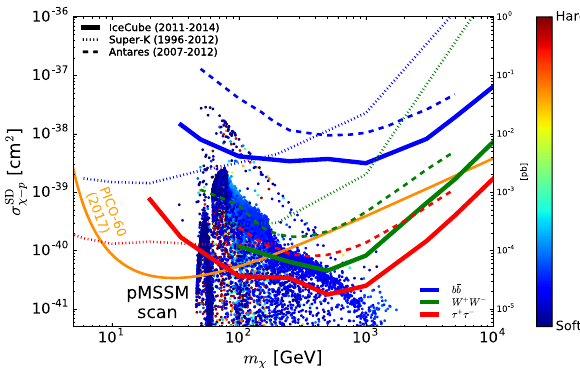
Fig. 23 IceCubelimitsonthespin-dependentWIMP-protonscattering cross section, σ SD χ − p as a function of WIMP mass, compared to results from other neutrino detectors and direct detection experiments [210, 218,219]. The IceCube limits have been scaled up to the upper edge of the 1 σ systematic uncertainty band. The coloured points correspond to models from a scan of the pMSSM. The model points are shown colour- coded according to the “hardness” of the resultant neutrino spectrum. Red points correspond to models that annihilate predominantly into harder channels (such as τ + τ − ) and can hence be excluded by the IceCube red line, while blue points correspond to models that favour annihilationsintosofterchannels(suchas b b )andareprobedbytheblue lines. Similar coding applies for intermediate colours. Figure adapted from